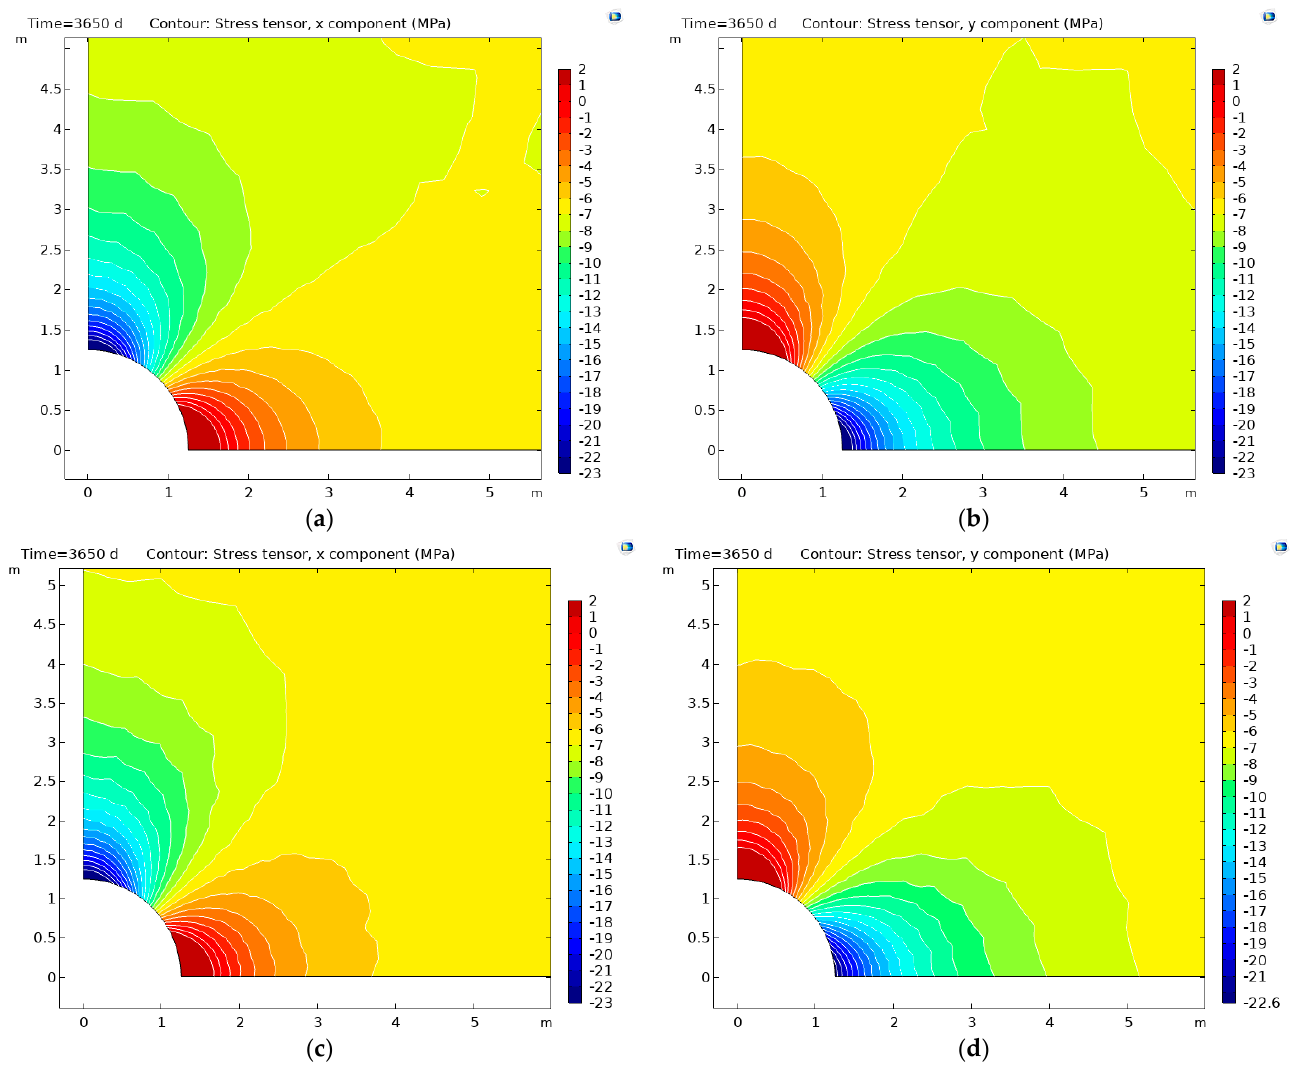
Figure 14. UDC variant: distribution of effective stress (x and y components) in the case of isotropic ( a , b ) and anisotropic ( c , d ) stress conditions properties by the end of the heating phase.